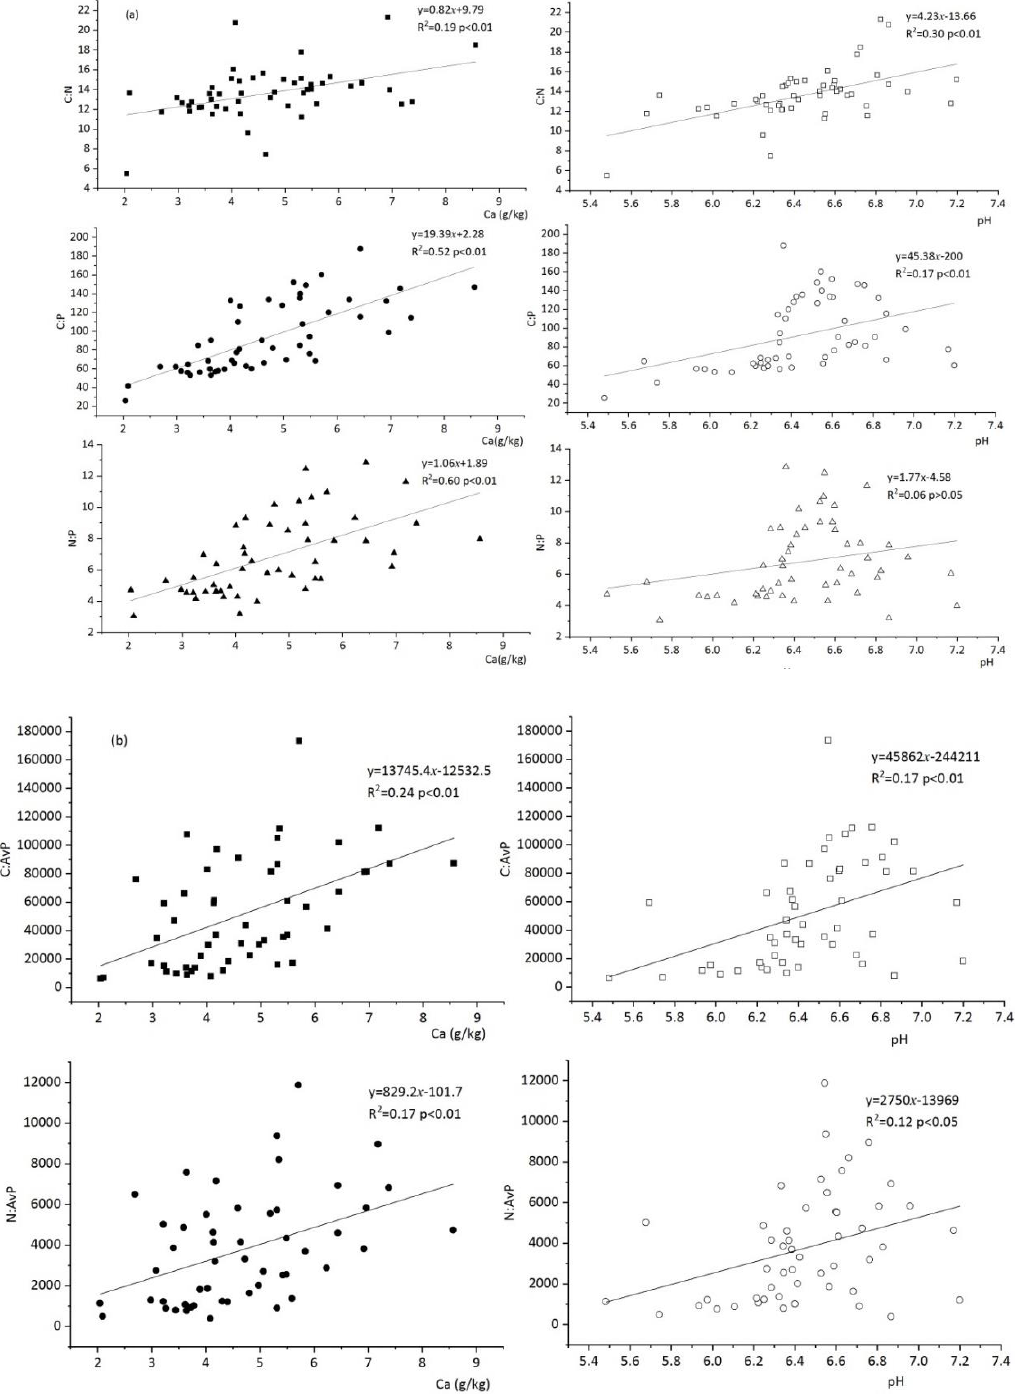
Figure 4. The relationship between Ca, pH, and C, N, and P stoichiometry. ( a ): The relationship 213 between Ca, pH, and C:N, C:P and N:P; ( b ): The relationship between Ca, pH, and C:AvP, N:AvP. 214